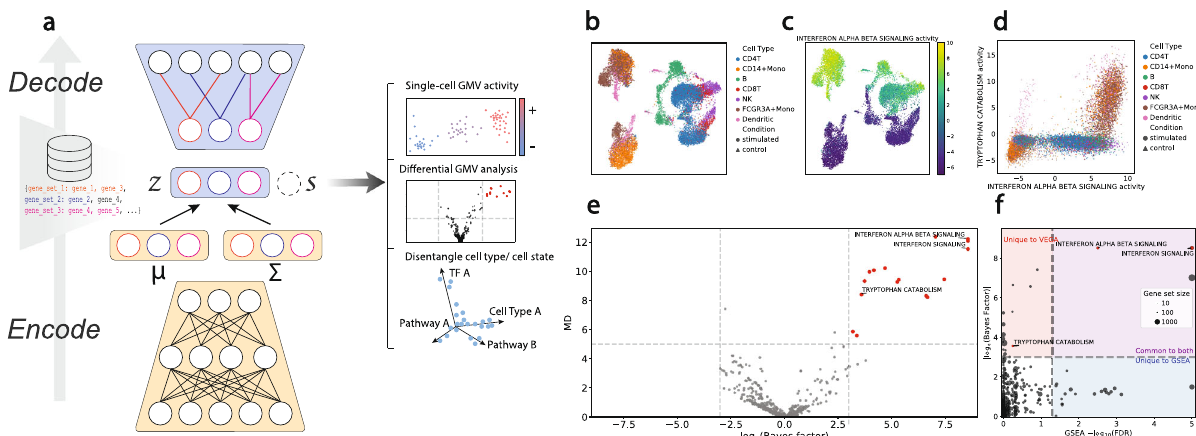
Fig. 1 Designing a novel VAE architecture with interpretable latent space. a Overview of the VEGA model. Composed of a deep nonlinear encoder ( μ , Σ ) and a masked linear decoder, VEGA represents single-cell transcriptomics data into a lower-dimensional interpretable latent space z that approximates a set of user-supplied gene modules (GMV). Additionally, VEGA can integrate batch information as another variable s to condition its generative process on batch labels. b UMAP embedding of the latent space of VEGA retains the biological signal of the Kang et al. PBMCs dataset 17 . c Inferred interferon-alpha/ beta signaling pathway activity segregates stimulated cells from the control population. d Bivariate GMV plot showing the ability of the model to recover the tryptophan catabolism activity, an innate (Dendritic cells, FCGR3A + monocytes, CD14 + monocytes) immune cell-speci fi c response to the perturbation. e Volcano plot showing differentially active GMVs between stimulated and control innate immune cells. The red dots indicate GMVs with ∣ log e (Bayes Factor) ∣ > 3 and a mean absolute difference (MD) in the latent space of at least 5. f Comparison of VEGA Bayes Factor with GSEA -log 10 (FDR). The size of the dots indicates the gene set size. The red, blue, and purple quadrants correspond respectively to signi fi cant hits unique to our model, unique to GSEA, and common to (Fig. 1b). Speci fi cally, we found that the interferon- α / β signaling